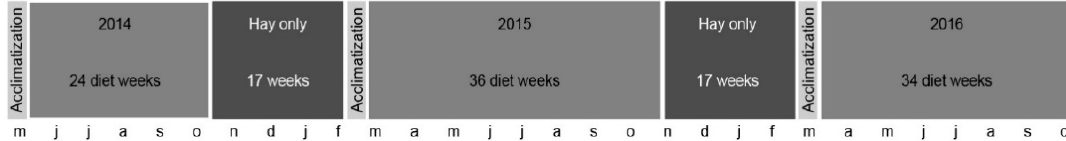
Figure 1. Study years 2014–2016 with the corresponding number of weeks that the diet was fed, and the corresponding calendar months (starting in May 2014) below the figure.